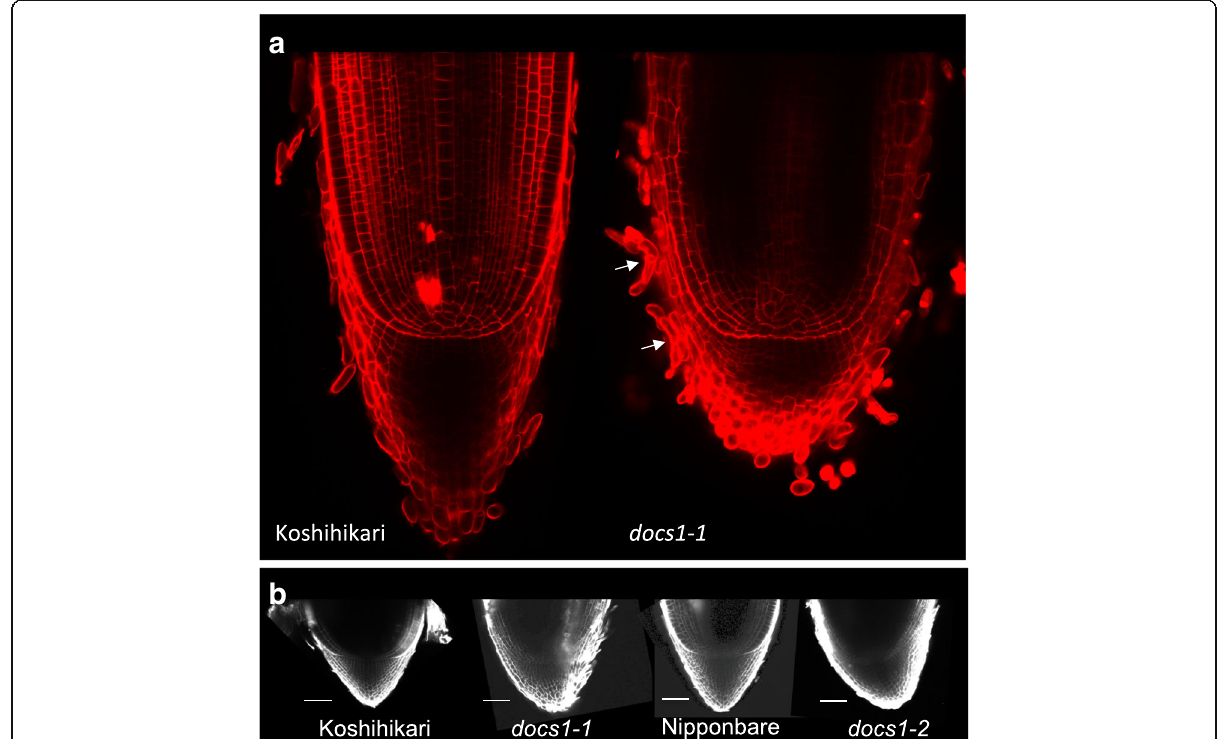
Fig. 4 Root cap phenotypes of docs1 mutants stained with propidium iodide and imaged with a mutiphotonic microscope. a Longitudinal view of 3 days old radicle root tips. Tip of the docs1 root cap seems shorter than control. Arrows point to lateral root cap cells which did not detach from other cells. b docs1 embryo root caps are bent and shifted from the the root central radial axis. Bars 50 μ